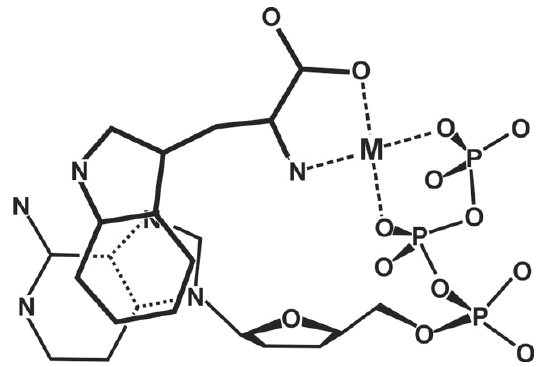
Figure 15. Tentative and schematic structure of the stacked isomer in solution of an M(ATP)(Trp) 3 − complex. Adapted from Ref [101].